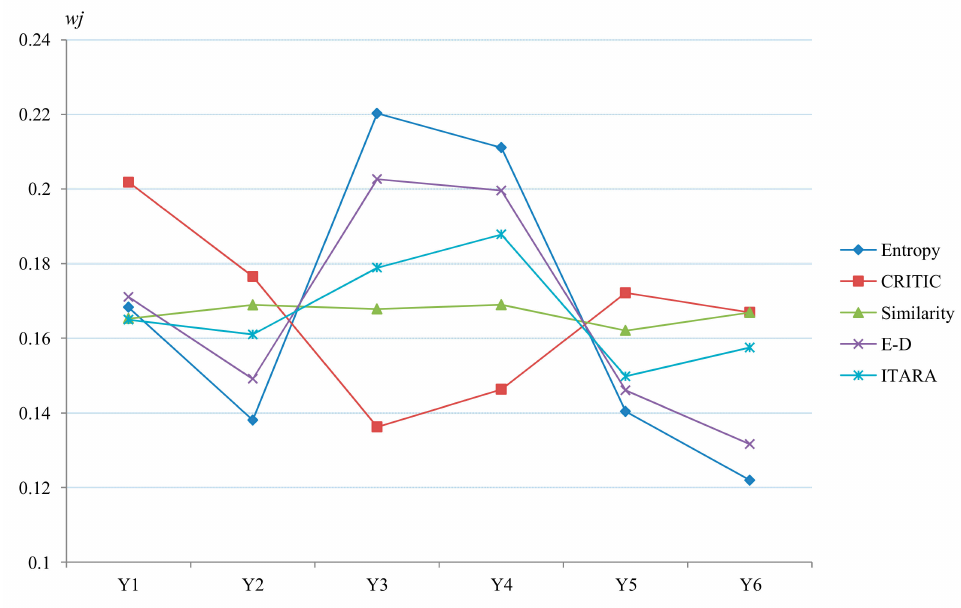
Figure 5. Comparison of weighting approaches.